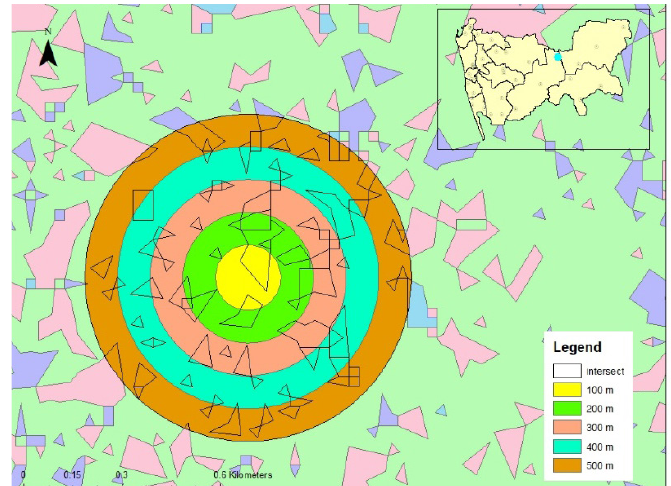
Figure 5: Intersecting land uses at selected buffer zones from a sampling point.